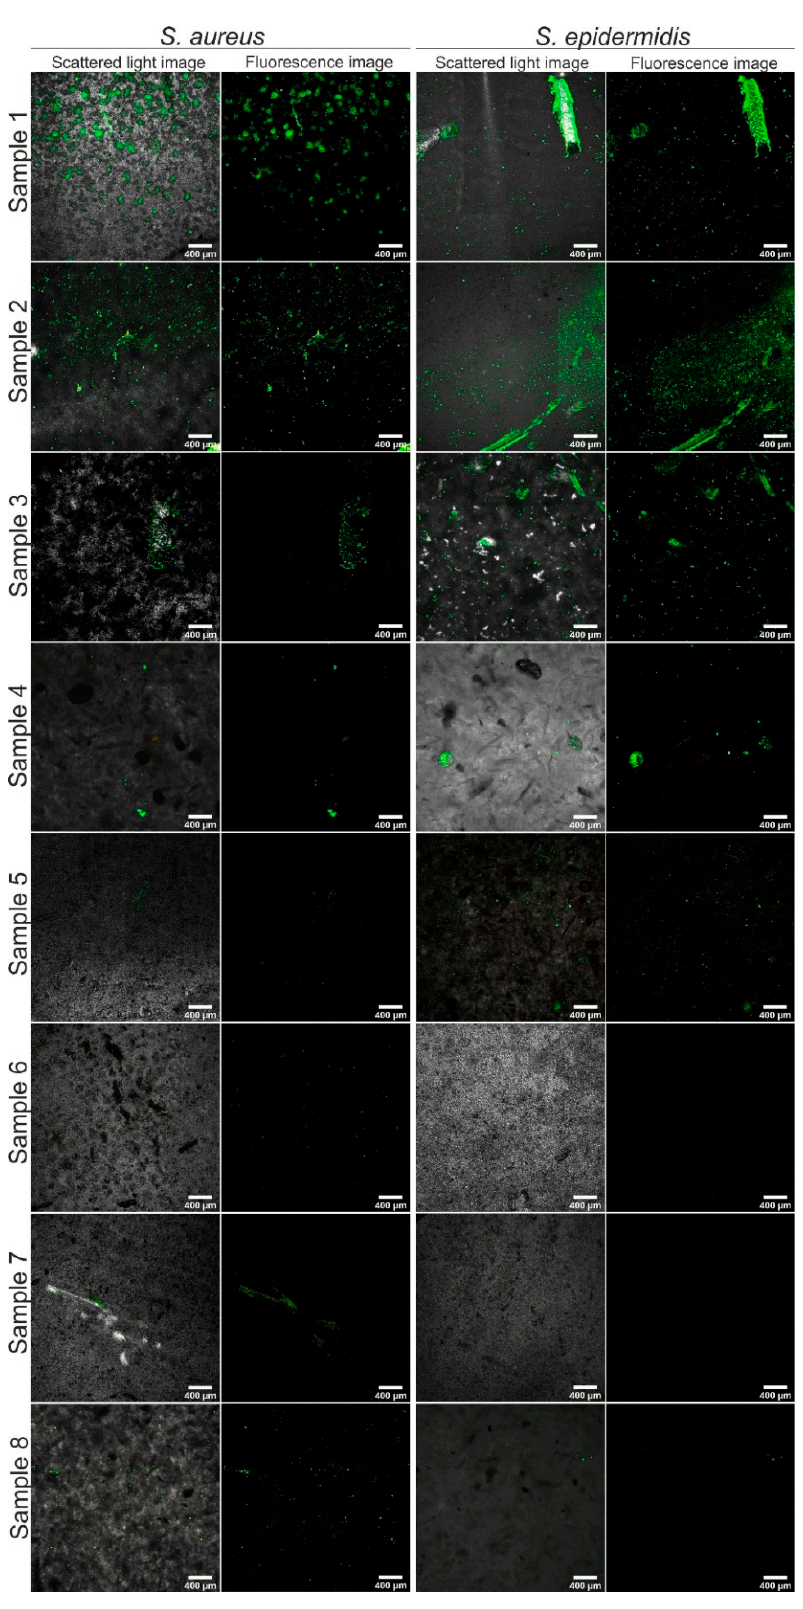
Figure 4. Confocal laser scanning microscope CLSM images showing Gram-positive strains biofilm formation (after 48 h of incubation) on tested materials: 1, control unmodified; 2–8, modified materials; magnification 40×; scale bar = 400 μ m.